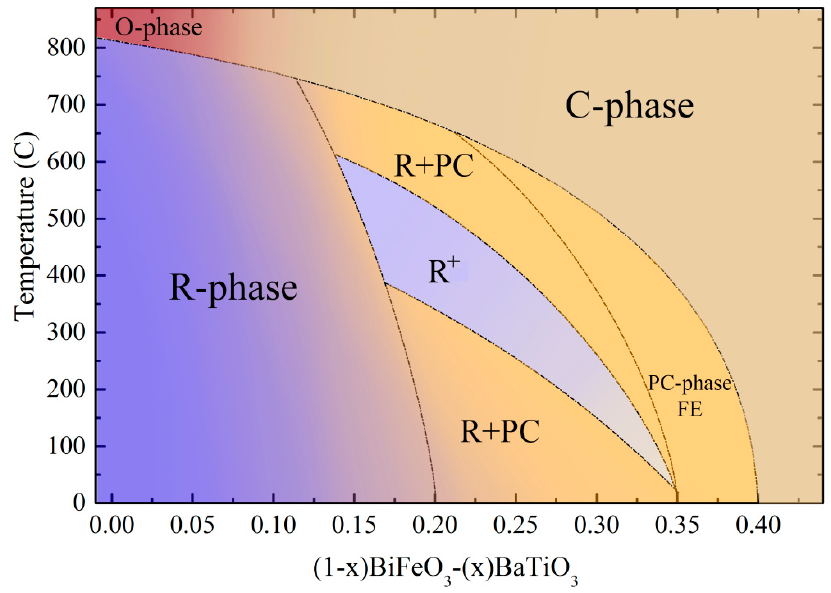
Figure 7. Structural phase diagram of the Bi 1 − x Ba x Fe 1 − x Ti x O 3 compounds with 0 < x < 0.5, the phase boundaries between single phase and phase coexistent states are drawn by the dot-dashed lines; the region ascribed to strengthening of the rhombohedral distortion is marked by as R + .